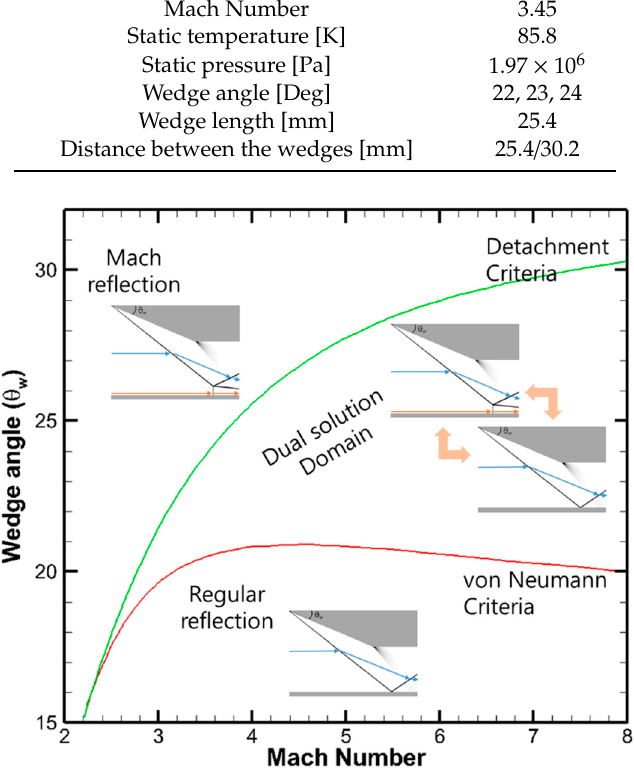
Figure 4. Domains of possible shock reflection configurations.